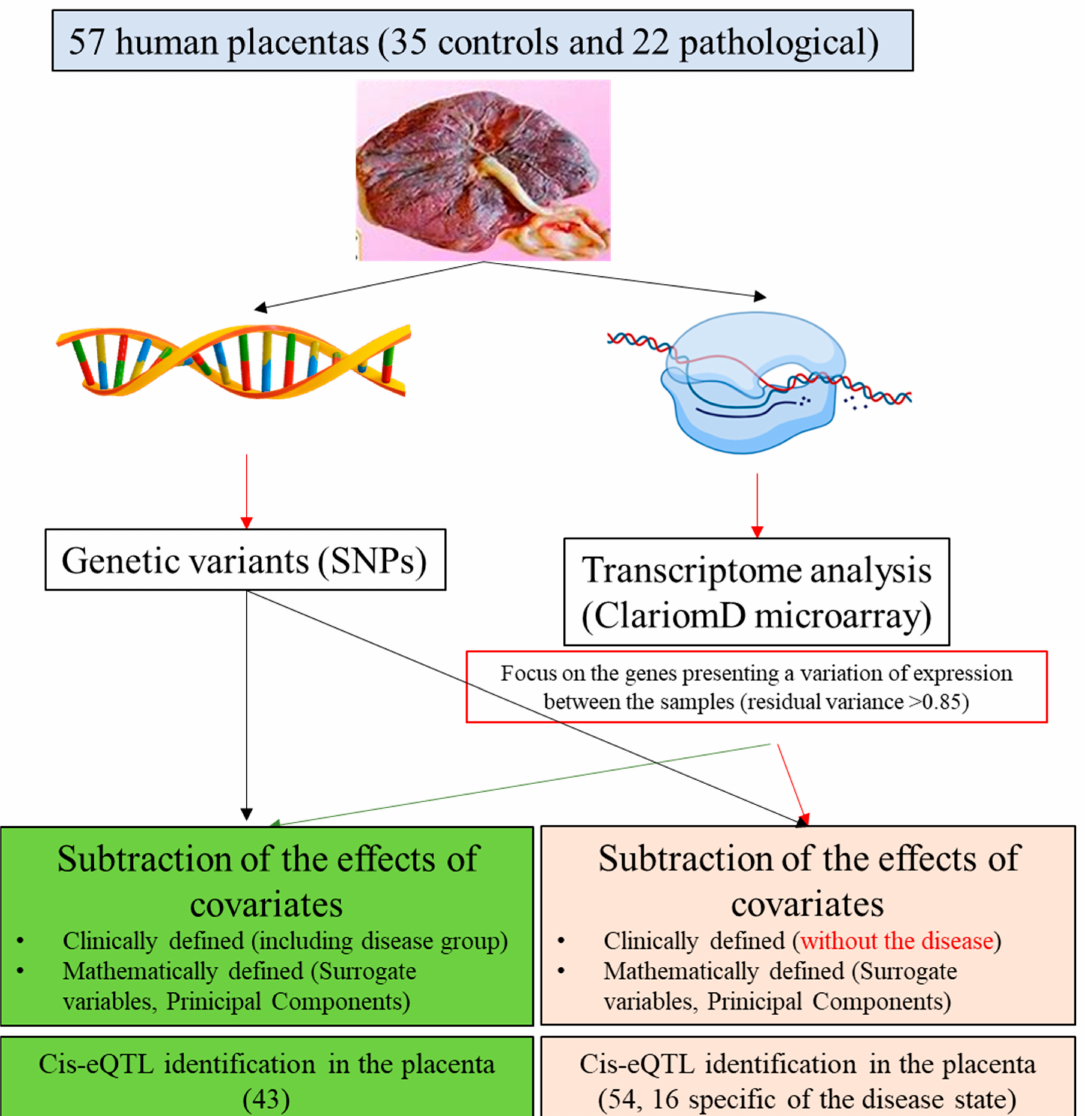
Figure 1. Overview of the experimental design. SNP = Single Nucleotide Polymorphism; PCA = Principal Component Analysis; SVA = Surrogate Variable Analysis; eQTL = expression Quantitative Trait